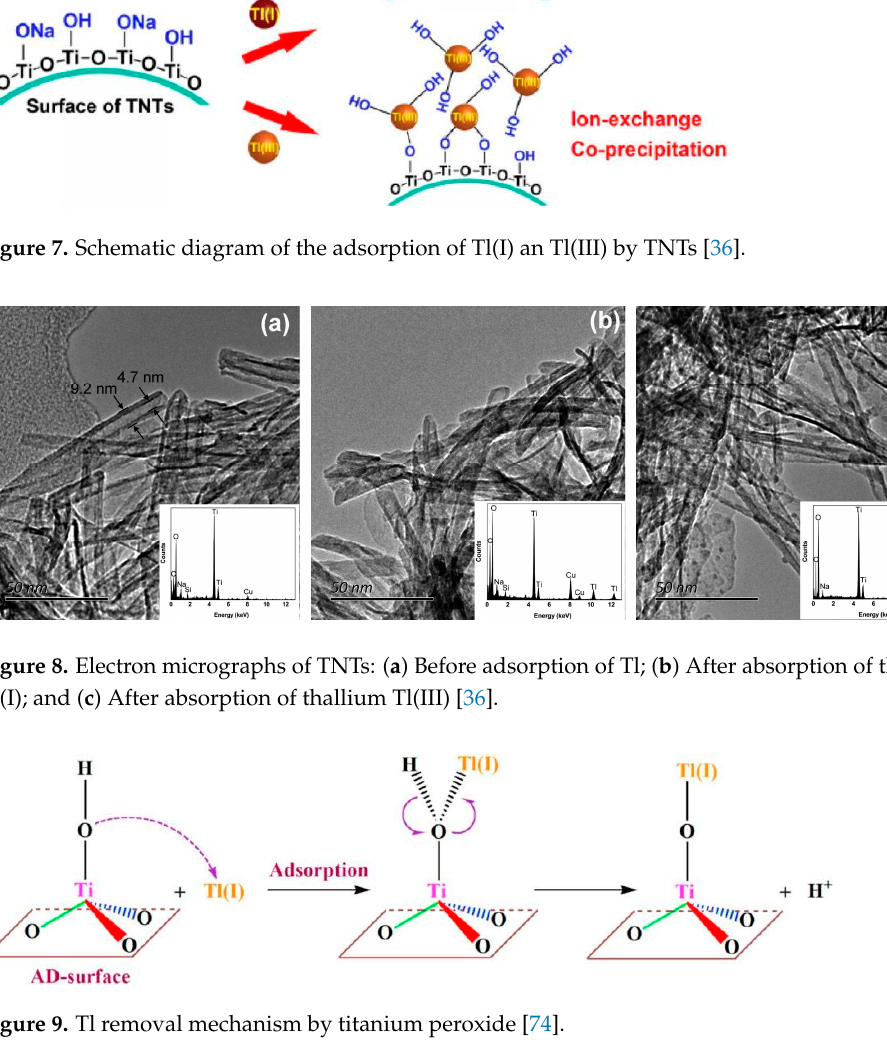
Figure 7. Schematic diagram of the adsorption of Tl(I) an Tl(III) by TNTs [36].